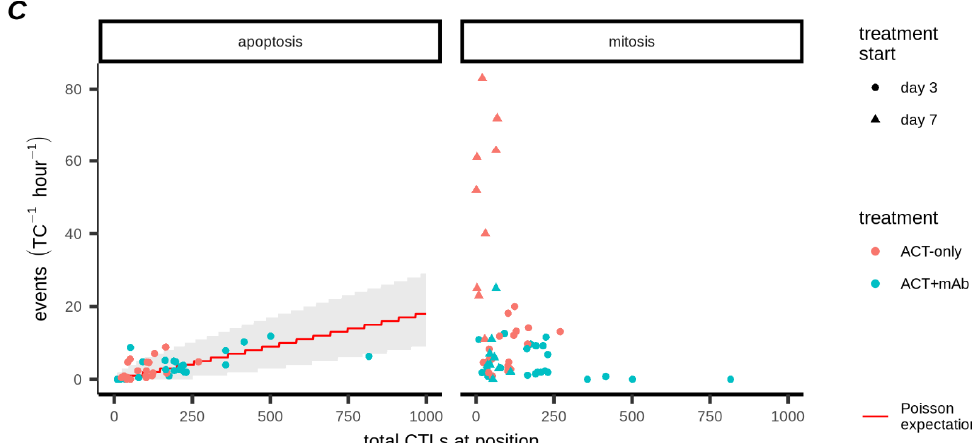
Figure 2. Impact of CTLs on the population dynamics of tumour cells. ( A ) Tumour volume measurements over time. Row 1: control tumours, either treated with ACT 3 days after inoculation but not expressing OVA (top left), or OVA expressing tumours not treated with ACT (top right). Rows 2 and 3: OVA expressing tumours treated with ACT 3 days (row 2) or 7 days (row 3) after inoculation, without anti-CD137 (left) or with anti-CD137 (right). ( B ) Volumetric growth rates of tumours corresponding to ( A ). Estimates of tumour growth rate are made over the interval between two successive volume measurements. Points representing estimates are displayed at the midpoint of the interval. Treatments for conditions are indicated in facet labels. Points in ( A , B ) are connected with straight lines visualizing the trajectories for individual mice. Points/lines corresponding to mice that had not (yet) received ACT are black, and green indicates that mice have received ACT. Grey lines in ( A , B ) represent the estimated growth rate of 0.5 day − 1 . ( C ) Relationship between the number of TC apoptosis events (left panel) or mitosis events (right panel) vs. number of CTLs per position. TC apoptosis and mitosis events are normalised (hour − 1 ) to account for differences in imaging time between positions. The expected number of kills per hour (red line) and 5–95% confidence interval (shaded region) are shown for a Poisson process where individual CTLs kill at a constant rate (0.44 CTL − 1 day − 1 ). See also Figure S3 for day 7 mitosis